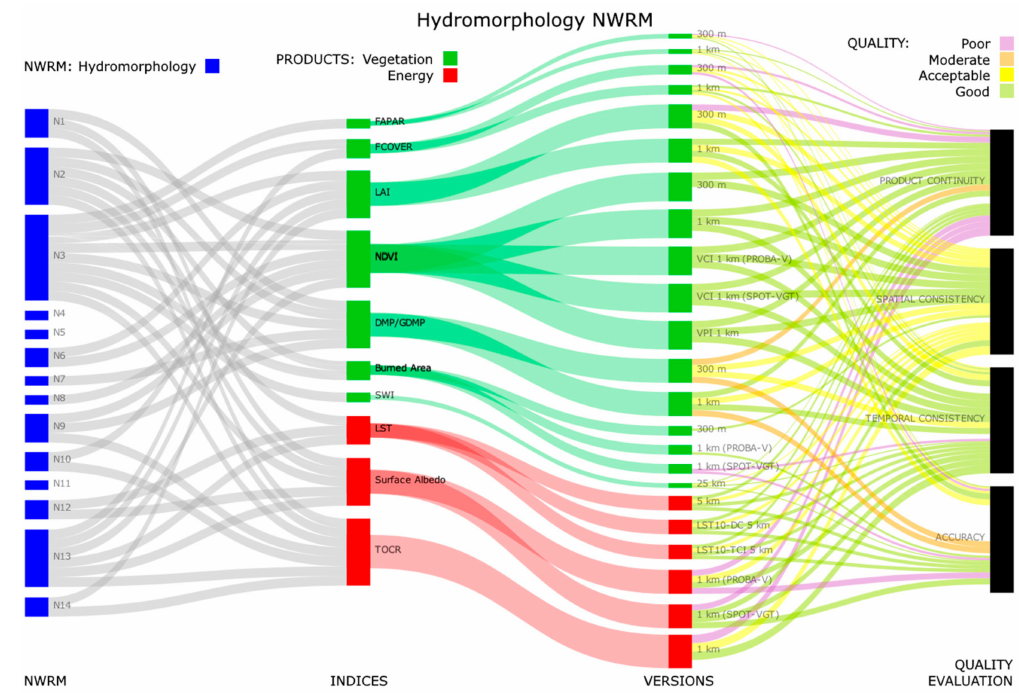
Figure A3. Sankey diagram linking the hydromorphology NWRM (N) and the CGLS vegetation and energy indices that are suitable for their monitoring, according to previous research experiences.